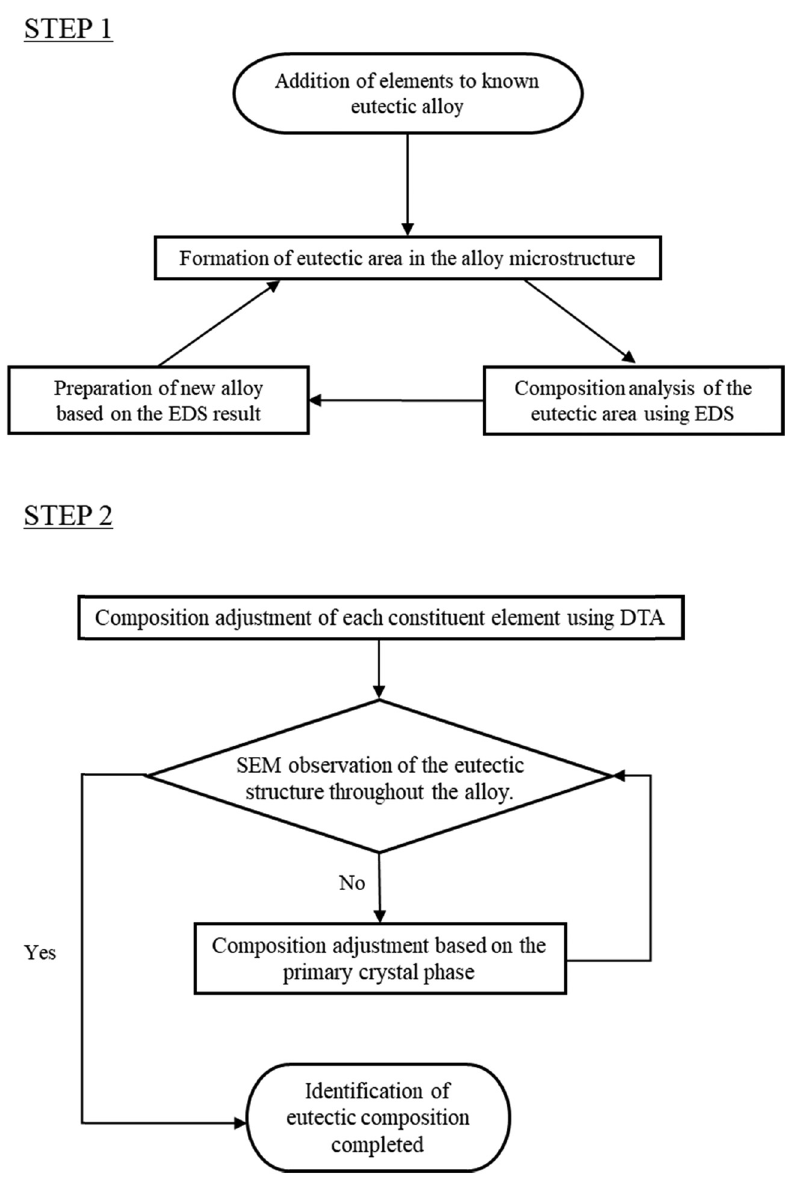
Figure 2: Flowchart of the eutectic composition identi fi cation process.